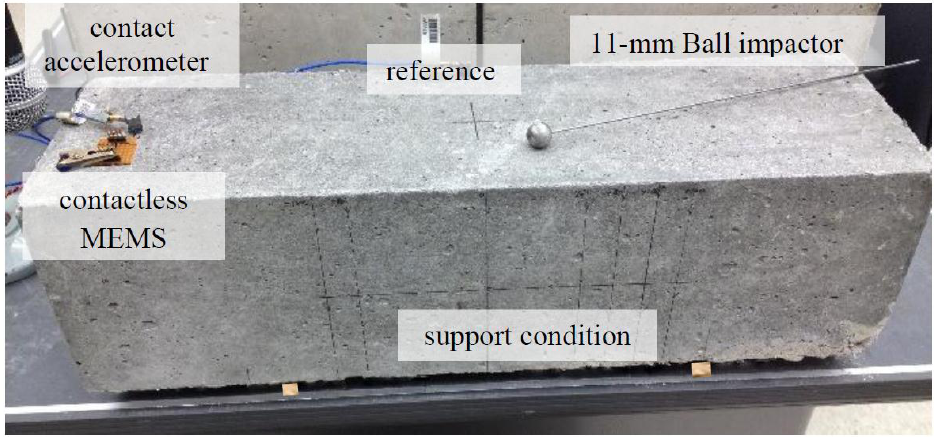
Figure 4. Vibration test configuration showing contactless MEMS sensor and contact accelerometer. Sample is 150 × 150 × 510 mm concrete